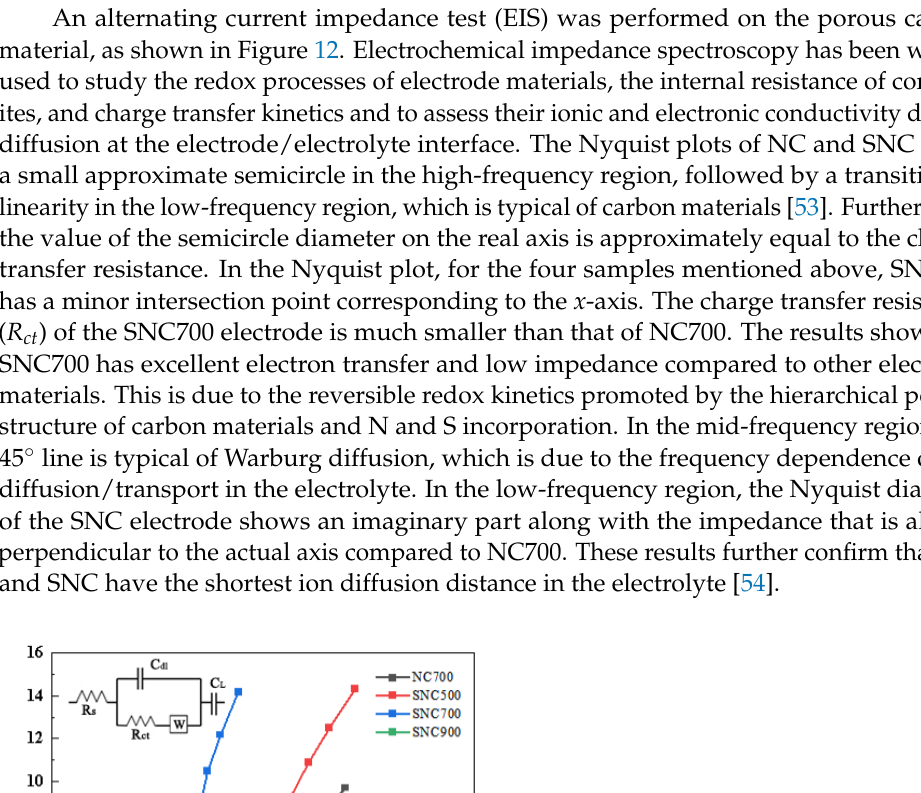
( b ) Figure 13. CV curves at different scanning rates ranging from 10 to 100 mV/s for NC700 ( a ) and SNC700 ( b ).